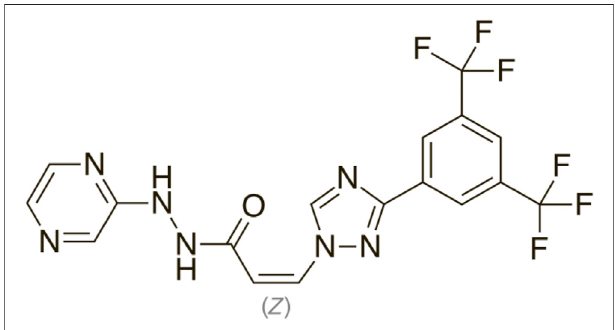
FIGURE 1 | Chemical structure of Selinexor.